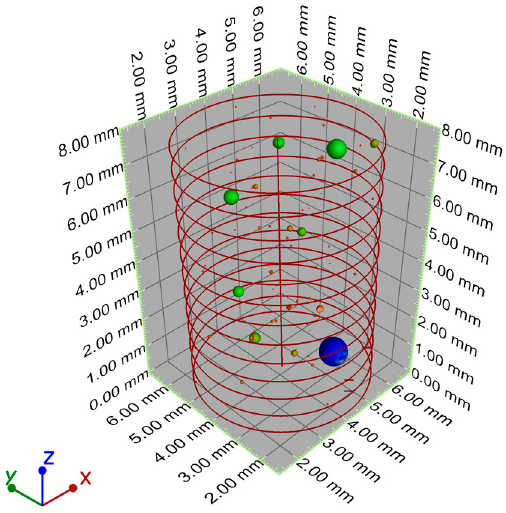
Figure 10. Rendering of spherical metallic inclusions contained in sample H.